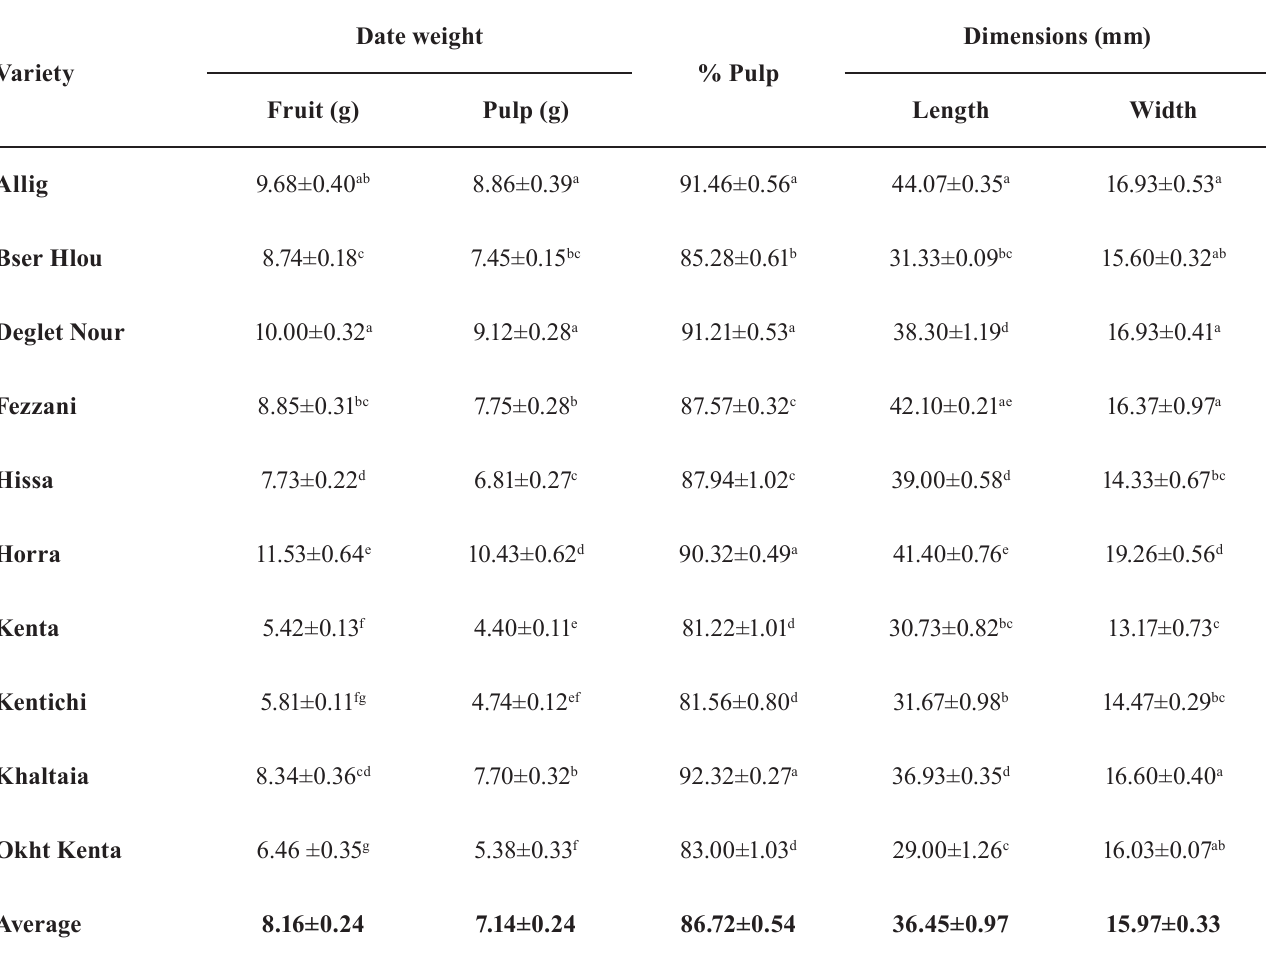
TABLE I - F ruit weight and pulp physical properties of ten date varieties at the Tamr stage Date weight Dimensions (mm) Variety % Pulp Fruit (g) Pulp (g) Length Width Allig 9.68±0.40